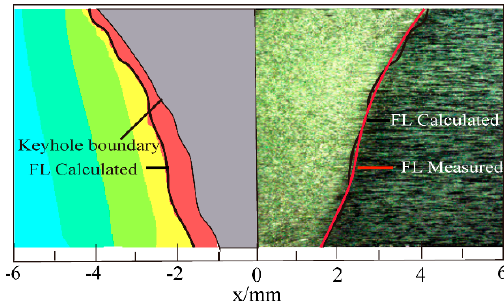
Figure 13. Comparison of the calculated and measured fusion line of case a.